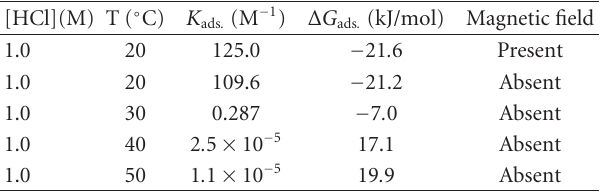
Table 3: Equilibrium constant and free energy of adsorption values for 1.0 hr in presence and absence of magnetic field.